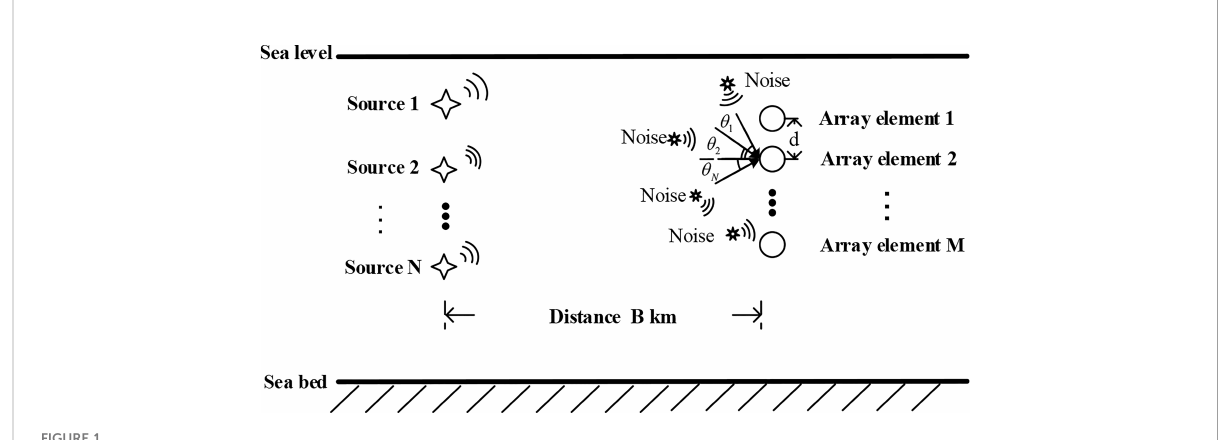
FIGURE 1 The DOA estimation model of an underwater acoustic array